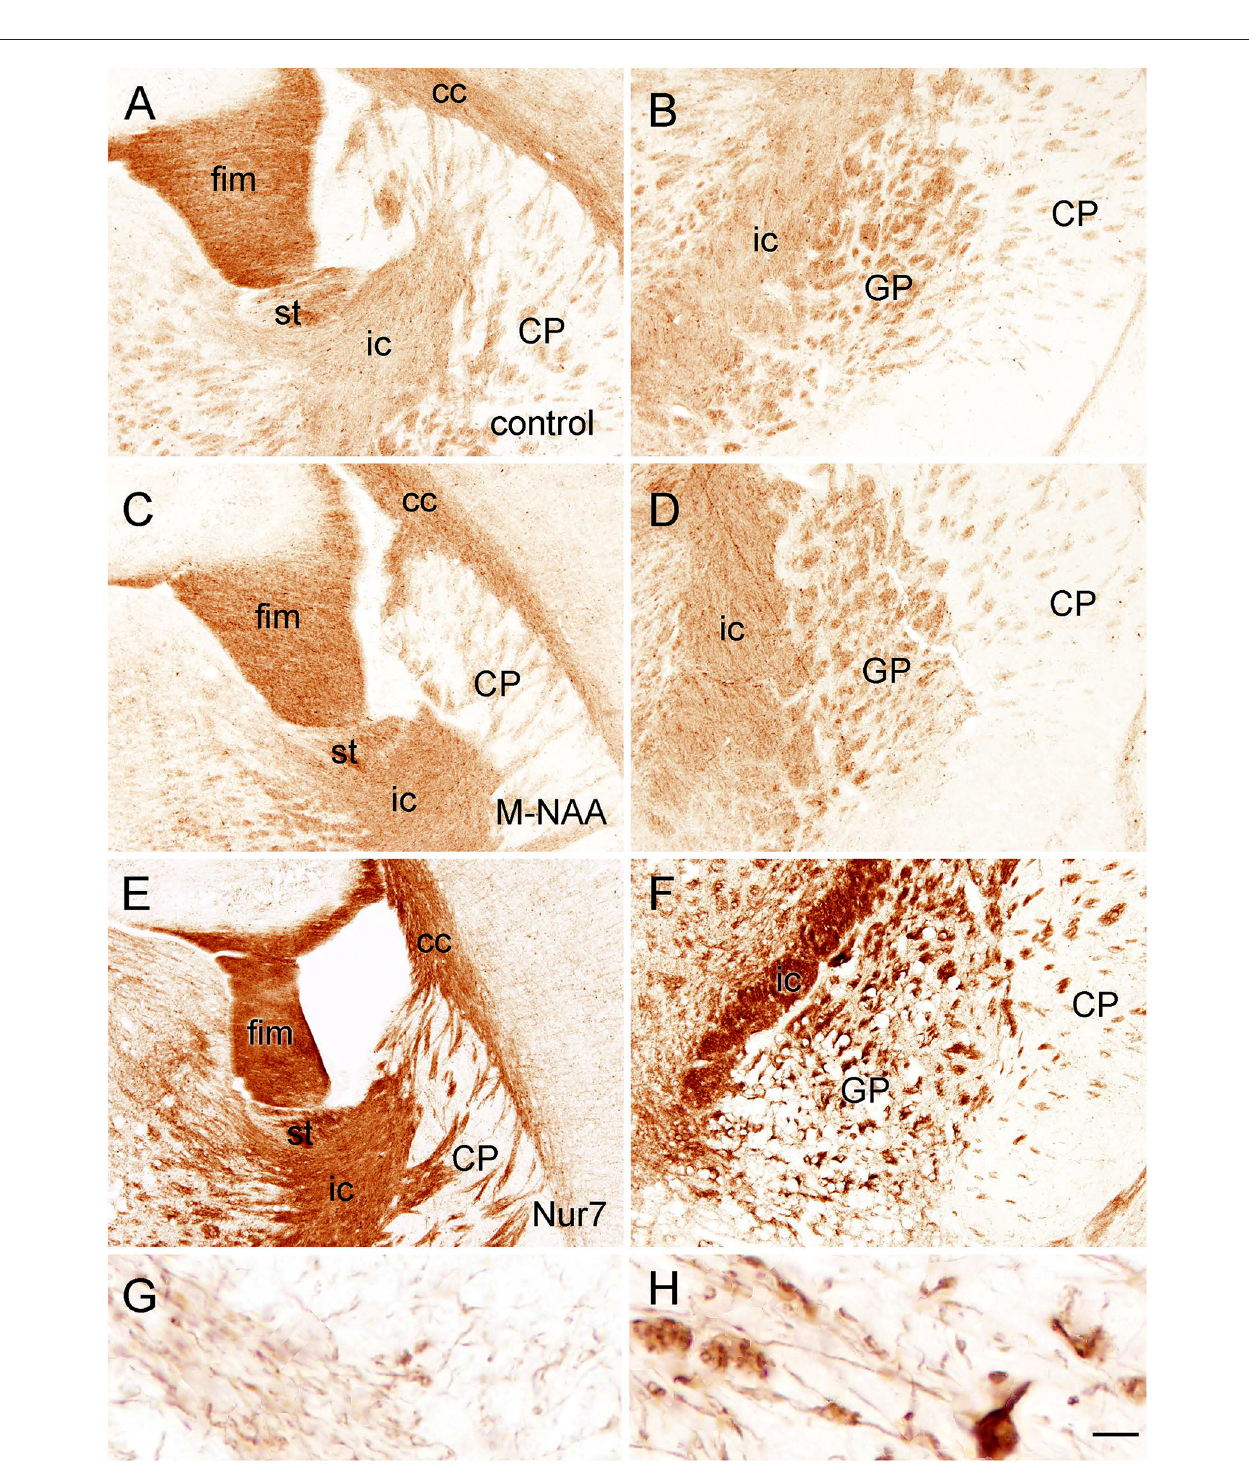
FIGURE 8 | Immunoreactivity for claudin-11 (also known as oligodendrocyte specific protein) in the forebrain. Staining for claudin-11 was moderate to strong in fiber pathways in control mice (A,B) , and there was no change in immunoreactivity with M-NAA treatment (C,D) . In contrast, Claudin-11 immunoreactivity was highly elevated in all fiber pathways in untreated Nur7 mice (E,F) . Major fiber pathways such as the fimbria of the hippocampus and internal capsule were reduced in thickness in Nur7 mice, suggesting axonal and oligodendrocyte loss. Oligodendrocyte processes were enlarged with swollen segments in Nur7 mice (H) as compared with controls (G) . Abbreviations: cc, corpus callosum; CP, caudate/putamen; fim, fimbria; ic, internal capsule; GP, globus pallidus; st, stria terminalis. Micron bar = 200 µ m in (A–F) , 10 µ m in (G,H) .